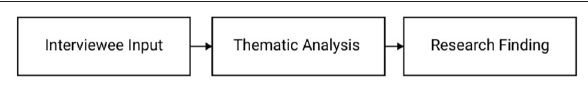
FIGURE 1 | Research methodology employed in